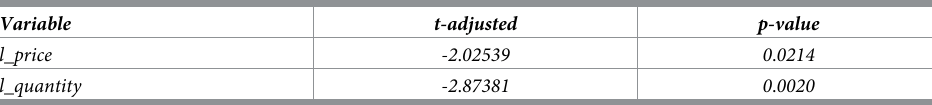
Table 5. Levin-Lin-Chu test